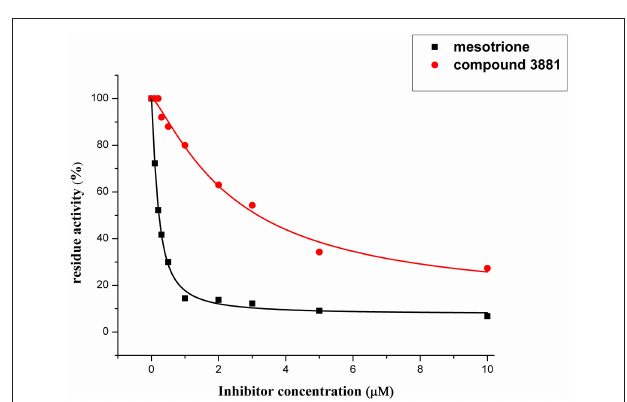
FIGURE 13 | Dose-dependent inhibitory curves of the mesotrione and compound 3881 against At HPPD.